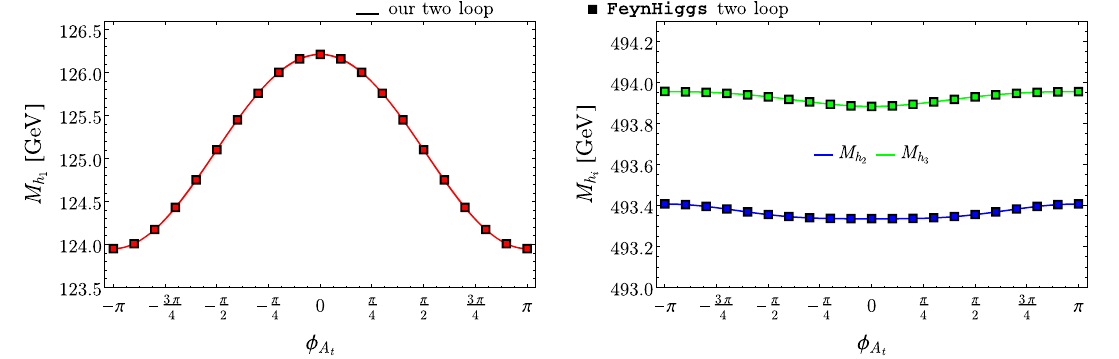
Fig. 1 Masses of the light, SM-like state h 1 ( left plot ) and the two heavy states h 2 and h 3 ( right plot ) as a function of φ A denote the masses obtained with our calculation, while the squares denote the masses obtained with FeynHiggs with the options indi-